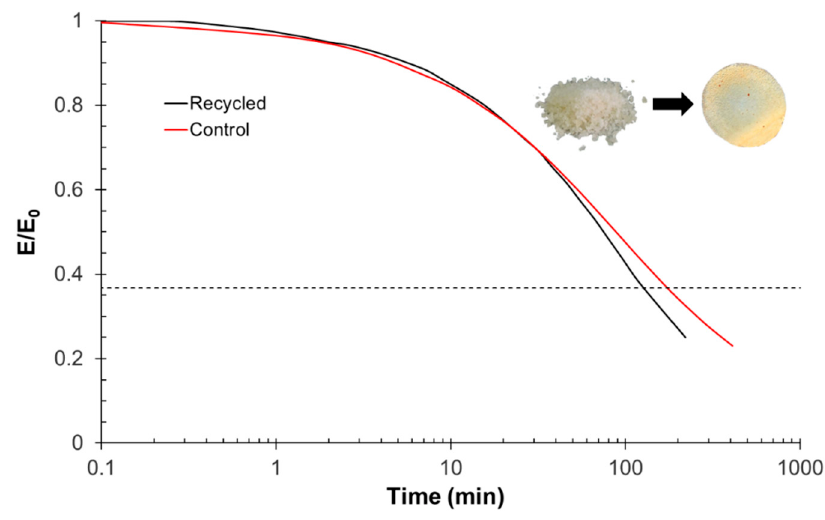
Figure 16. Stress relaxation of recycled FEMA 3D 25 in comparison to its pristine counterpart. Characteristic relaxation time ( 𝐸 𝐸 (cid:3415) (cid:3404) 1/𝑒 ) is marked with a dashed line. Inset: Ground sample before recycling ( left ); recycled sample after removal from hot press ( right ).